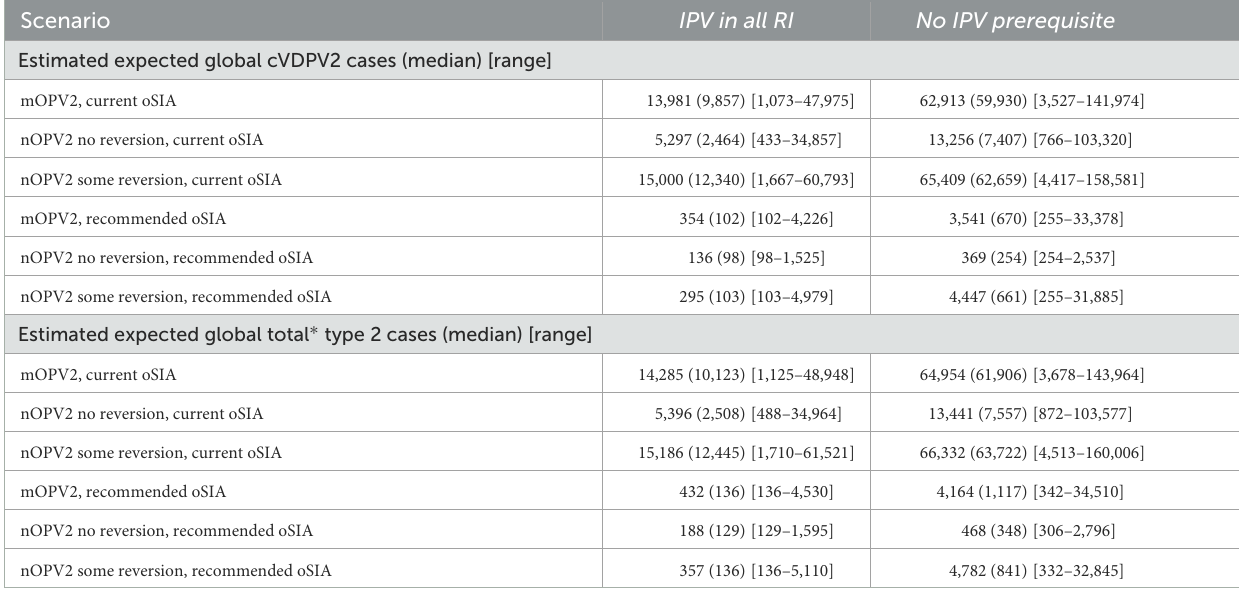
TABLE 3 Estimated expected value (median) and [range] of poliovirus cases in 100 stochastic iterations for 2016–2026 for the scenarios modeled. Scenario